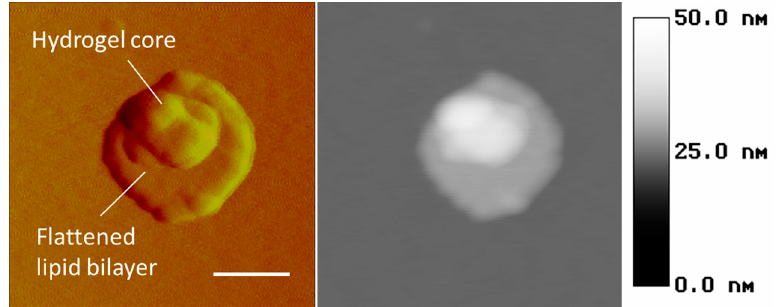
Figure 9. Atomic force microscopy images (amplitude and height data) of a PNIPA nanolipobead resulted from polymerization within a large unilamellar vesicle (LUV) (scale bar = 100 nm, right insert is the height scale). The lipobead was deposited on mica as described in Section 4.